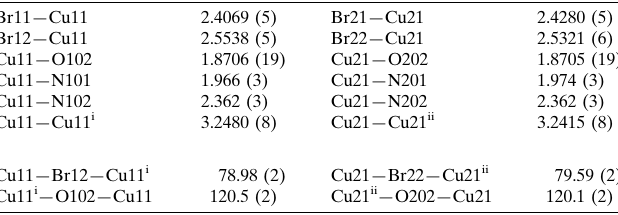
Selected geometric parameters (A˚ , (cid:2)